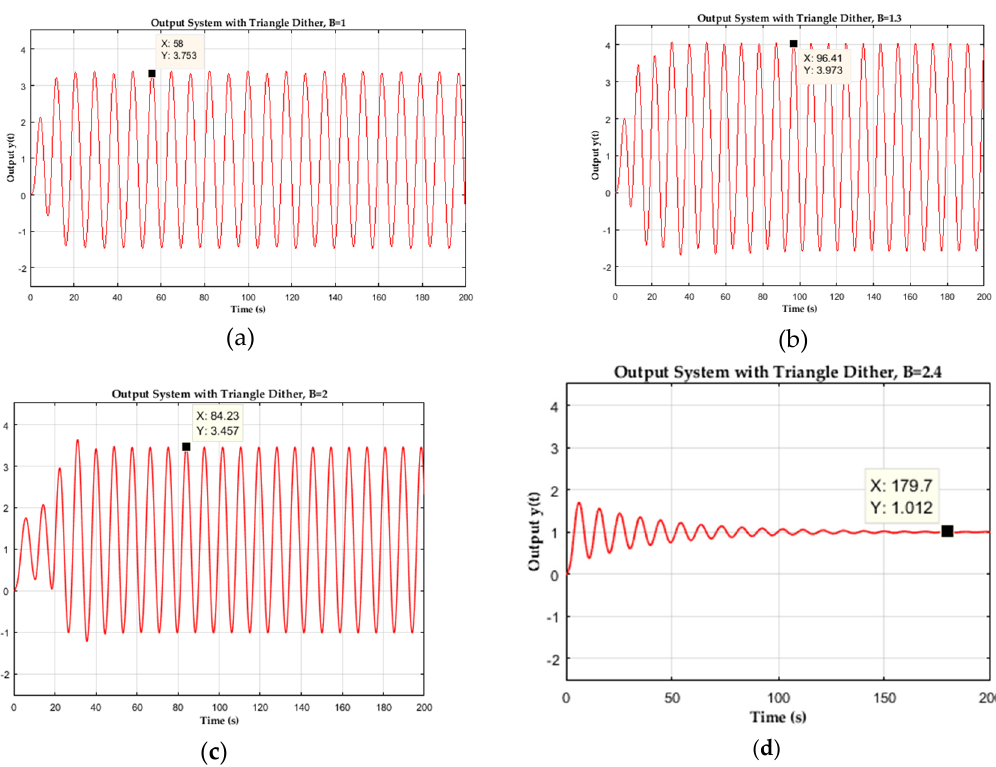
Figure 8. Closed-loop step response with Triangle wave dither injection, ( a ) with dither amplitude B = 1, ( b ) B = 1.3, ( c ) B = 2, ( d ) B = 2.4